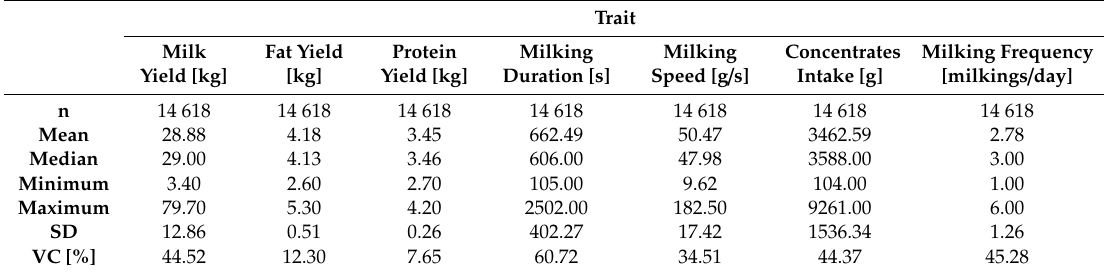
Table 3. Basic descriptive statistics of considered traits for daily milkings.